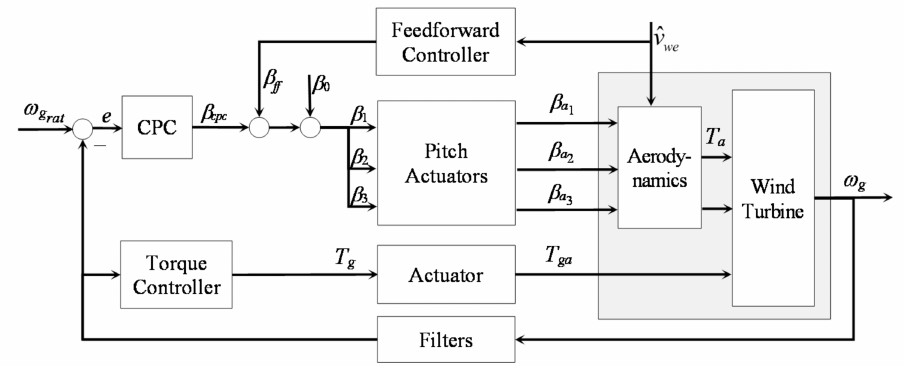
Figure 6. Power delimiter control as additional control loop for the collective pitch control